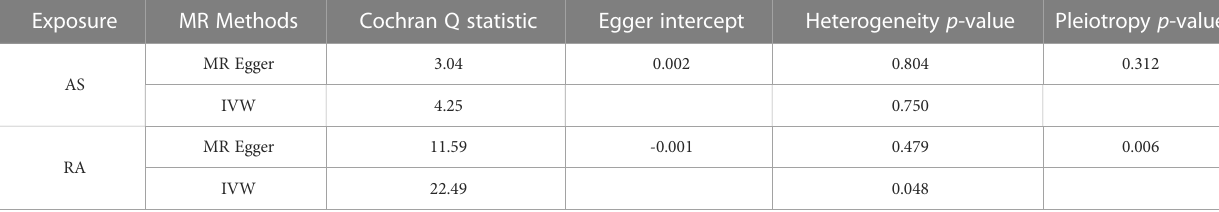
TABLE 4 Heterogeneity and pleiotropy analysis in reverse MR analysis. Exposure